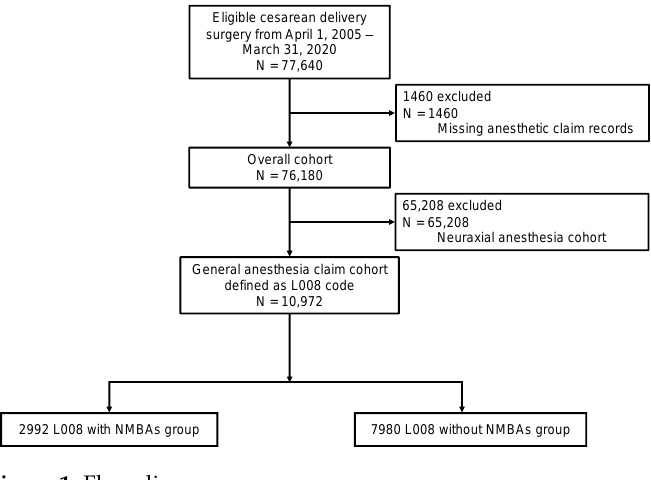
Figure 1. Flow diagram.